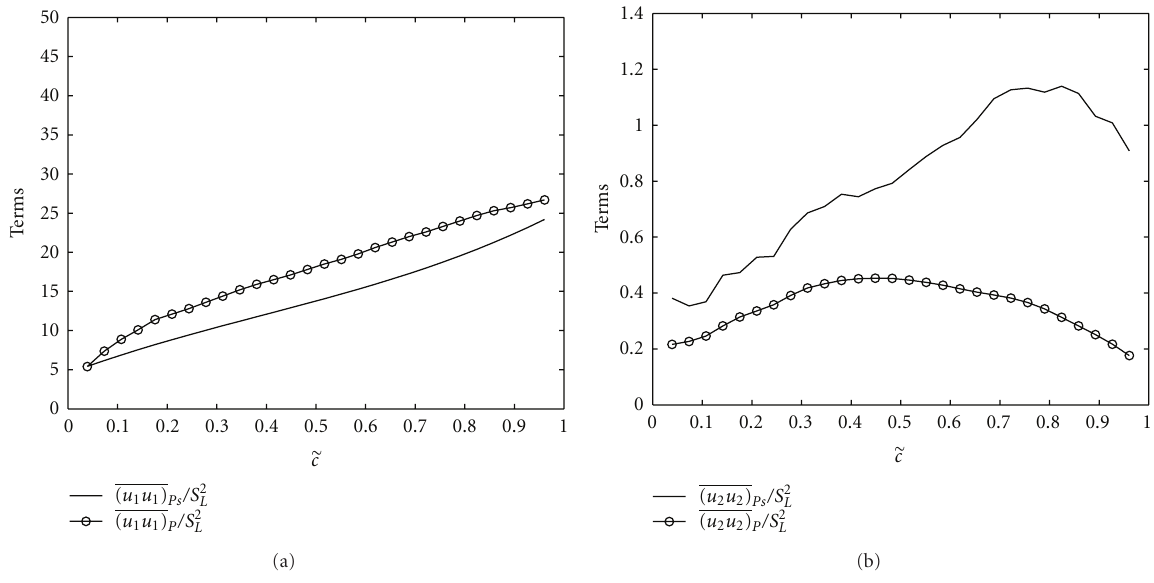
2 and ( u 1 u 1 ) Ps /S L